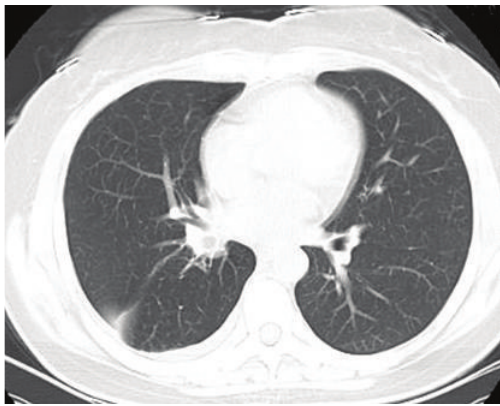
Figure 5: Axial CT showed the occlusion of right inferior basal branch.